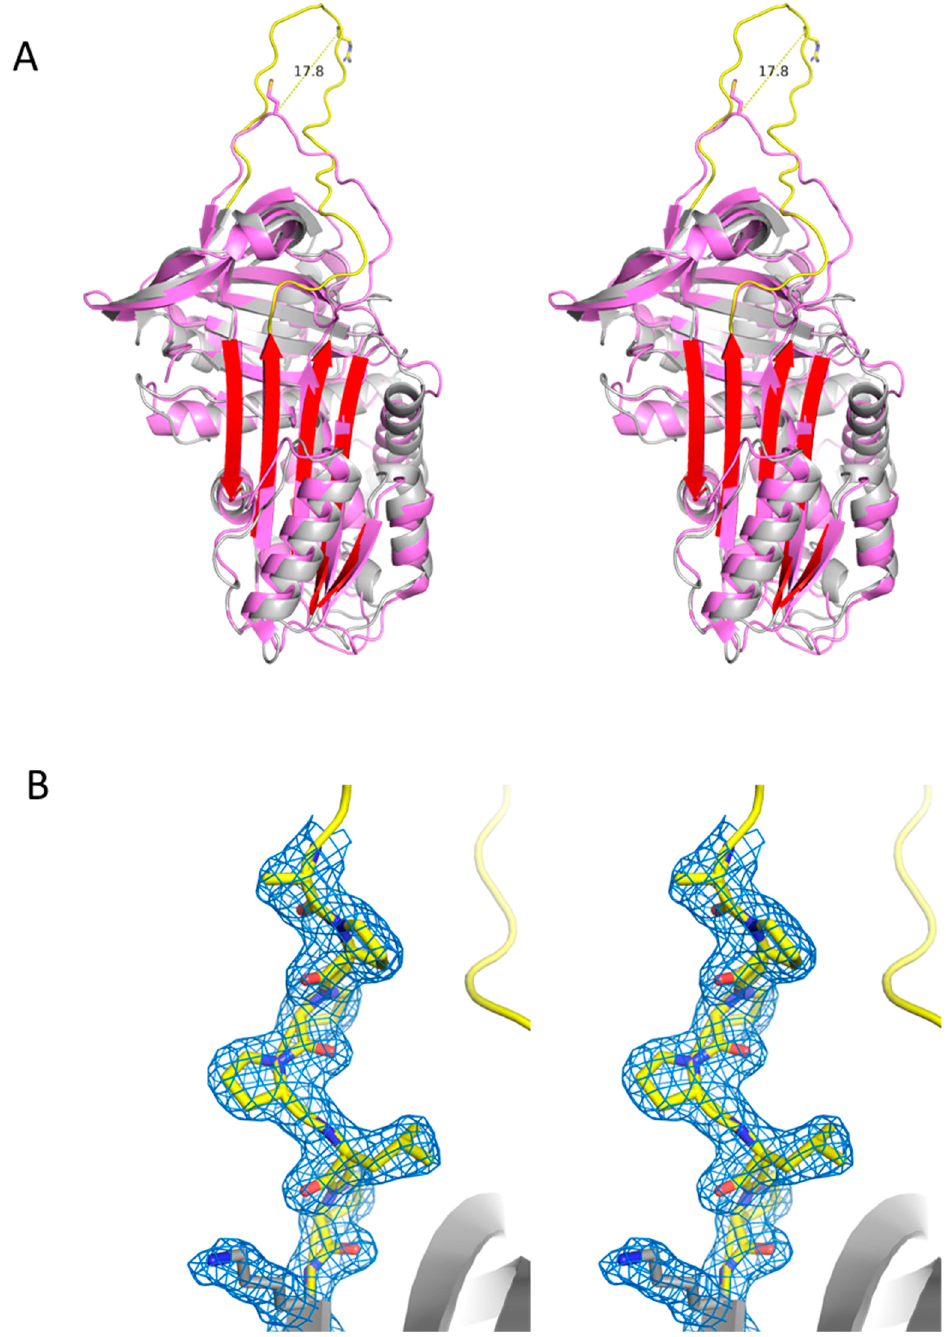
Figure 5. Crystal structure of native Iripin-8. ( A ) Stereo view of a ribbon diagram of Iripin-8 (gray with yellow RCL and red beta sheet A) superimposed with alpha-1-antitrypsin (PDB code 3ne4). The P1 side chains of both molecules are represented as sticks, and the distance between their C α atoms is shown. ( B ) Stereo view of a close-up of the P (cid:48) region with surrounding electron density (contoured at 1 times the RMSD of the map), forming a rigid type II polyproline